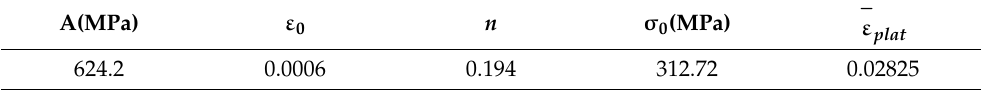
Figure 6. Comparison of experimental and simulated force-displacement curves for NT.